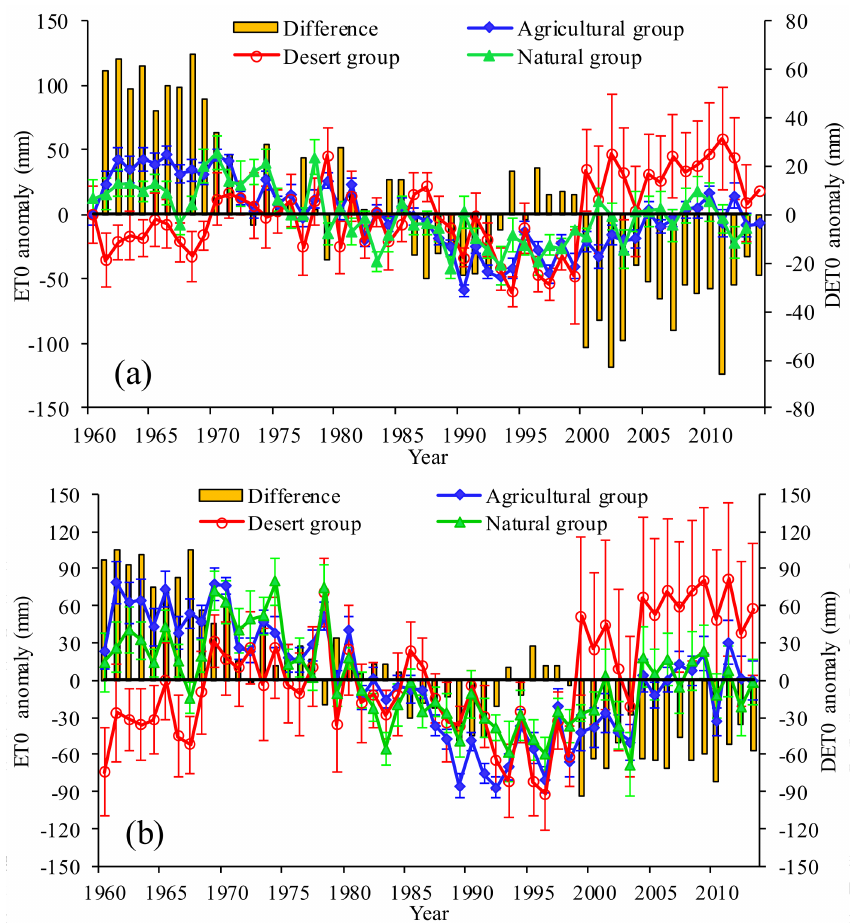
Figure 7. Time series of average ET0 anomalies for the different station groups. ( a ) summer and ( b ) growing season. The difference indicates the ET0 anomaly differences between the agricultural group and the desert group. The error bar indicates standard deviation of mean summer and growing ET0